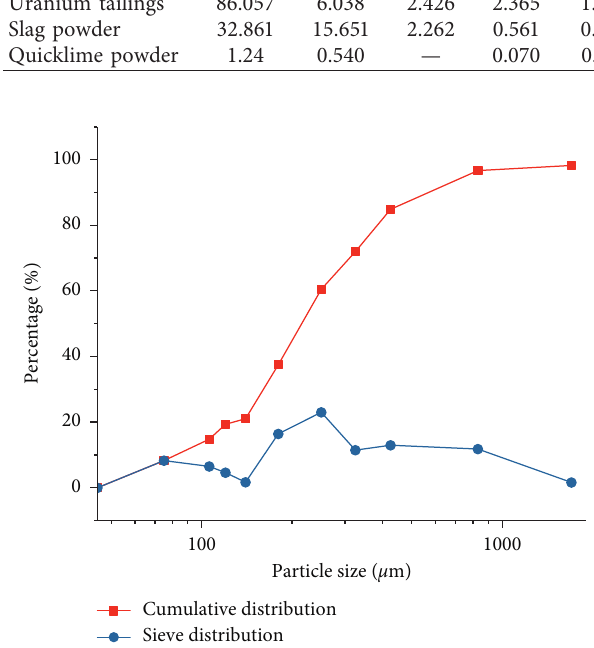
Figure 2: Particle size accumulation curve of uranium tailings.